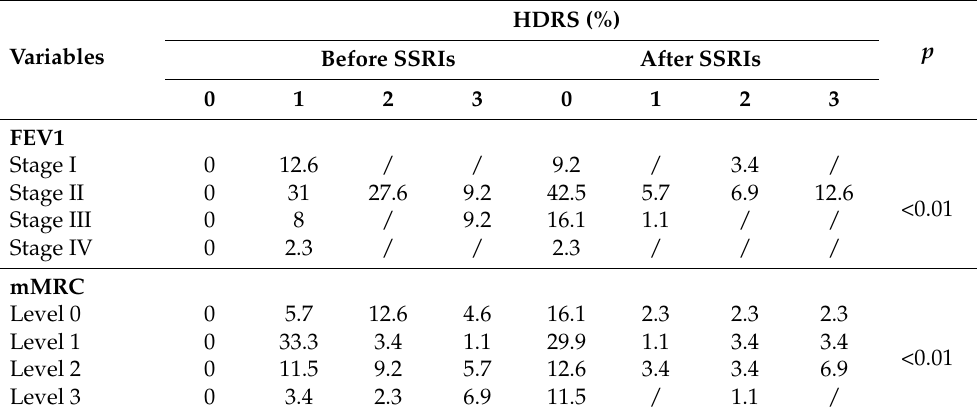
Table 2. Severity of depressive disorder (graded according to group scores on HDRS) levels before and after SSRI therapy according to FEV1 and